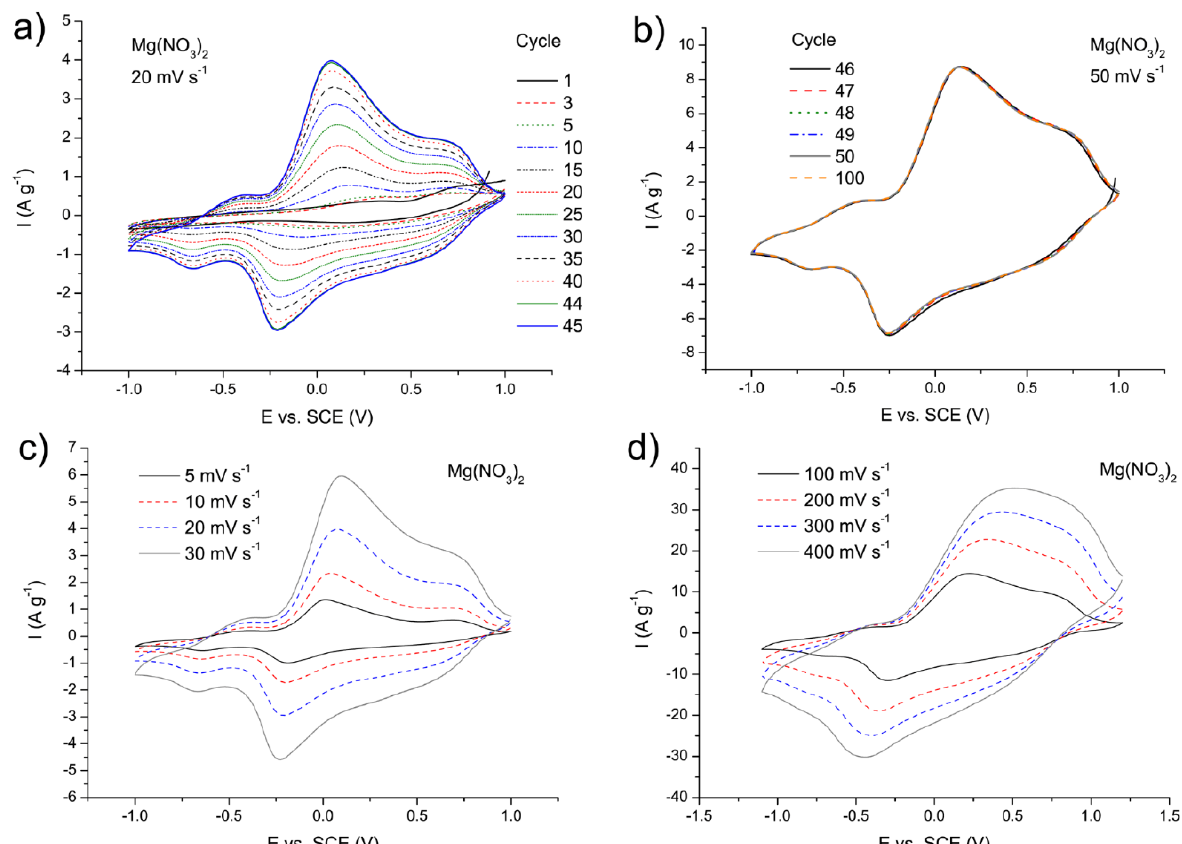
Figure 9. Cyclic voltammograms of the MgVO/C recorded in 3M Mg(NO 3 ) 2 solution: at 20 mV s −1 ( a ); at 50 mV s −1 after 45 successive cycles previously recorded at 20 mV s −1 using the same working electrode ( b ); at 5 – 30 mVs −1 ( c ); at 100 – 400 mVs −1 ( d ).